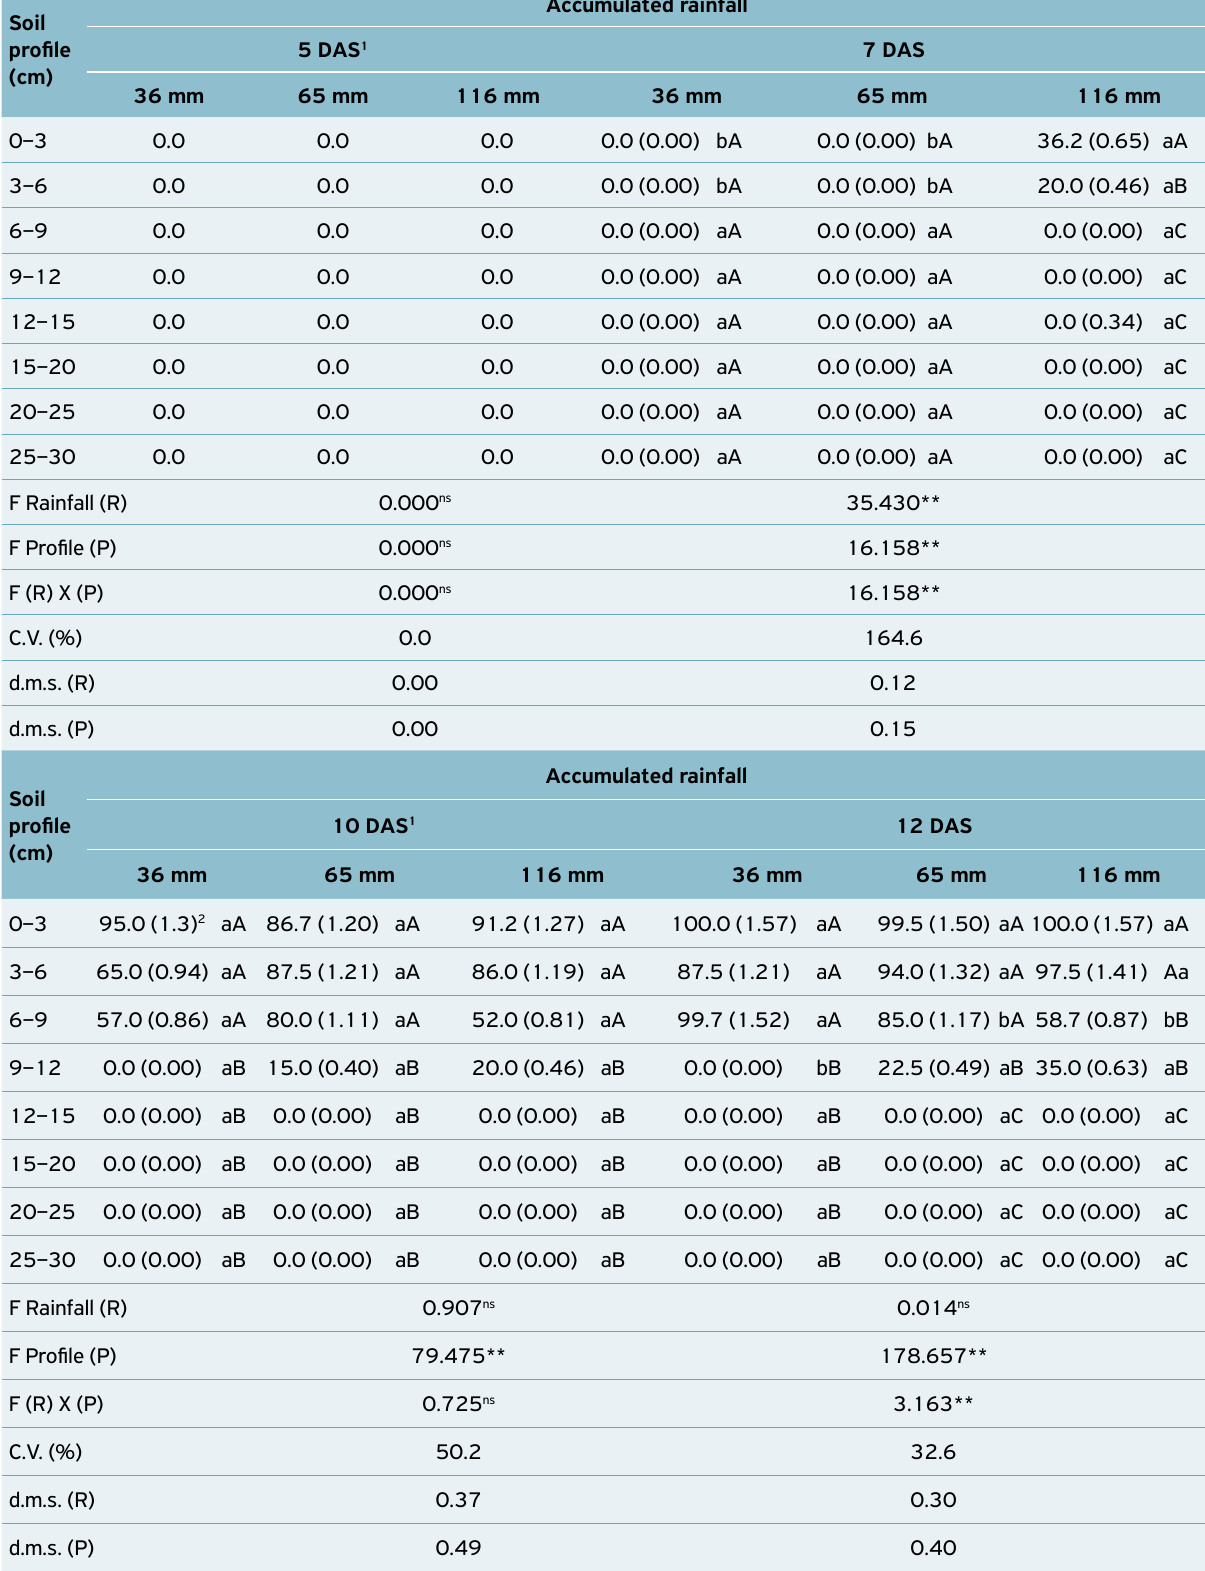
Table 6. Phytotoxicity percentage in lettuce plants after the application of tebuthiuron to a medium sandy-textured soil under different rainfall amounts. Botucatu, São Paulo,